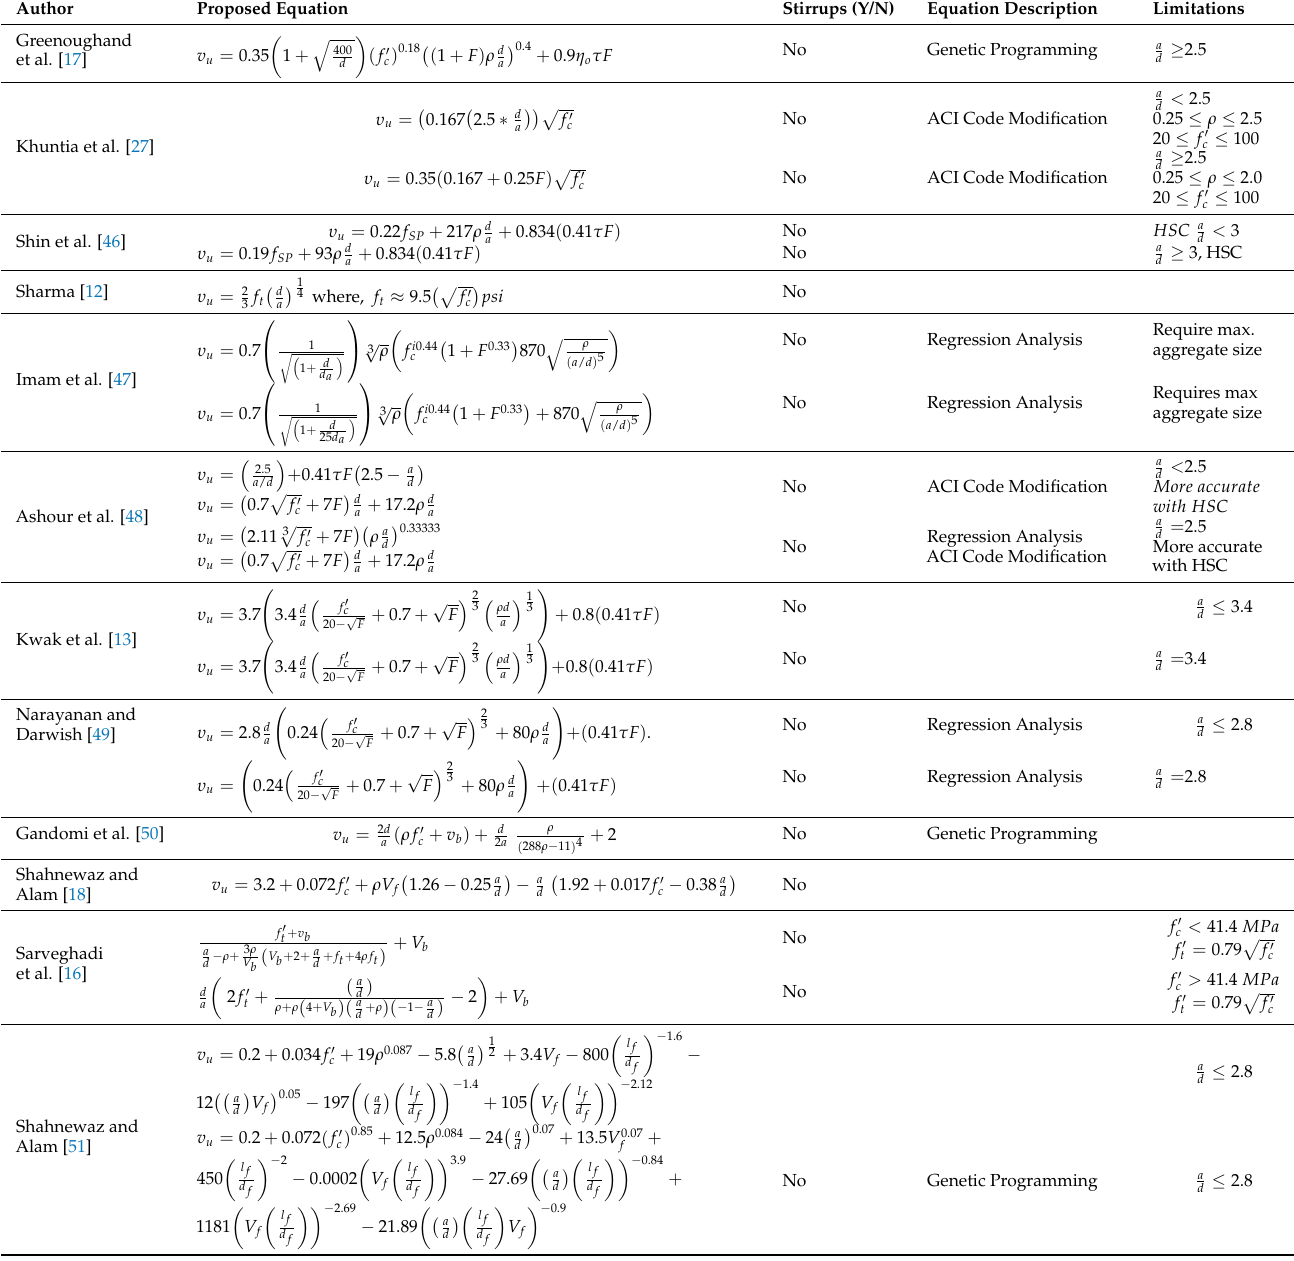
Table 1. Available shear strength models of steel fiber reinforced (steel fiber reinforced concrete (SFRC)) concrete